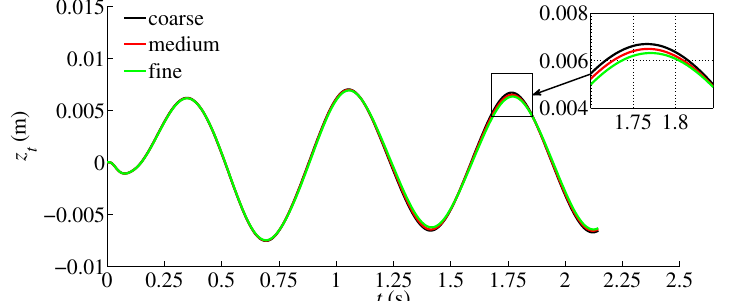
Figure 4. Comparison on the displacement of trailing edge with three different mesh resolutions.